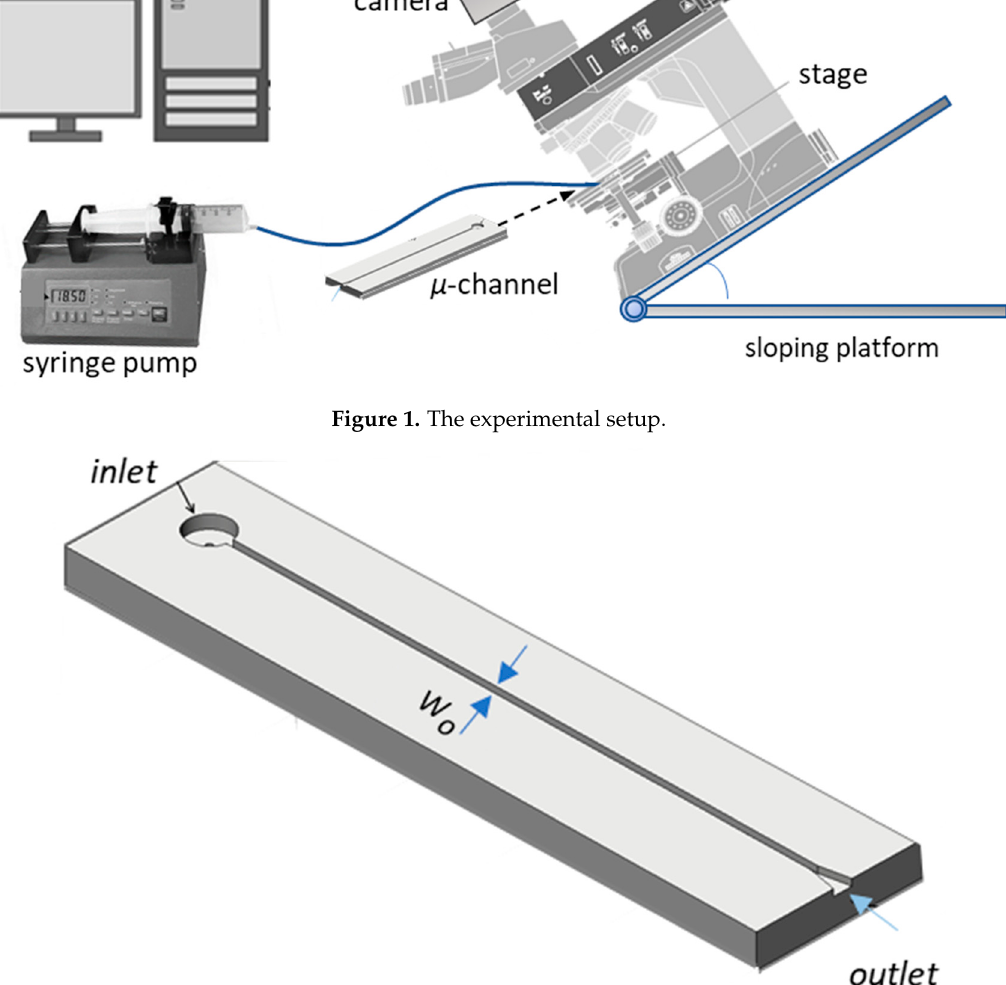
Figure 2. Details of the brass μ -channel.